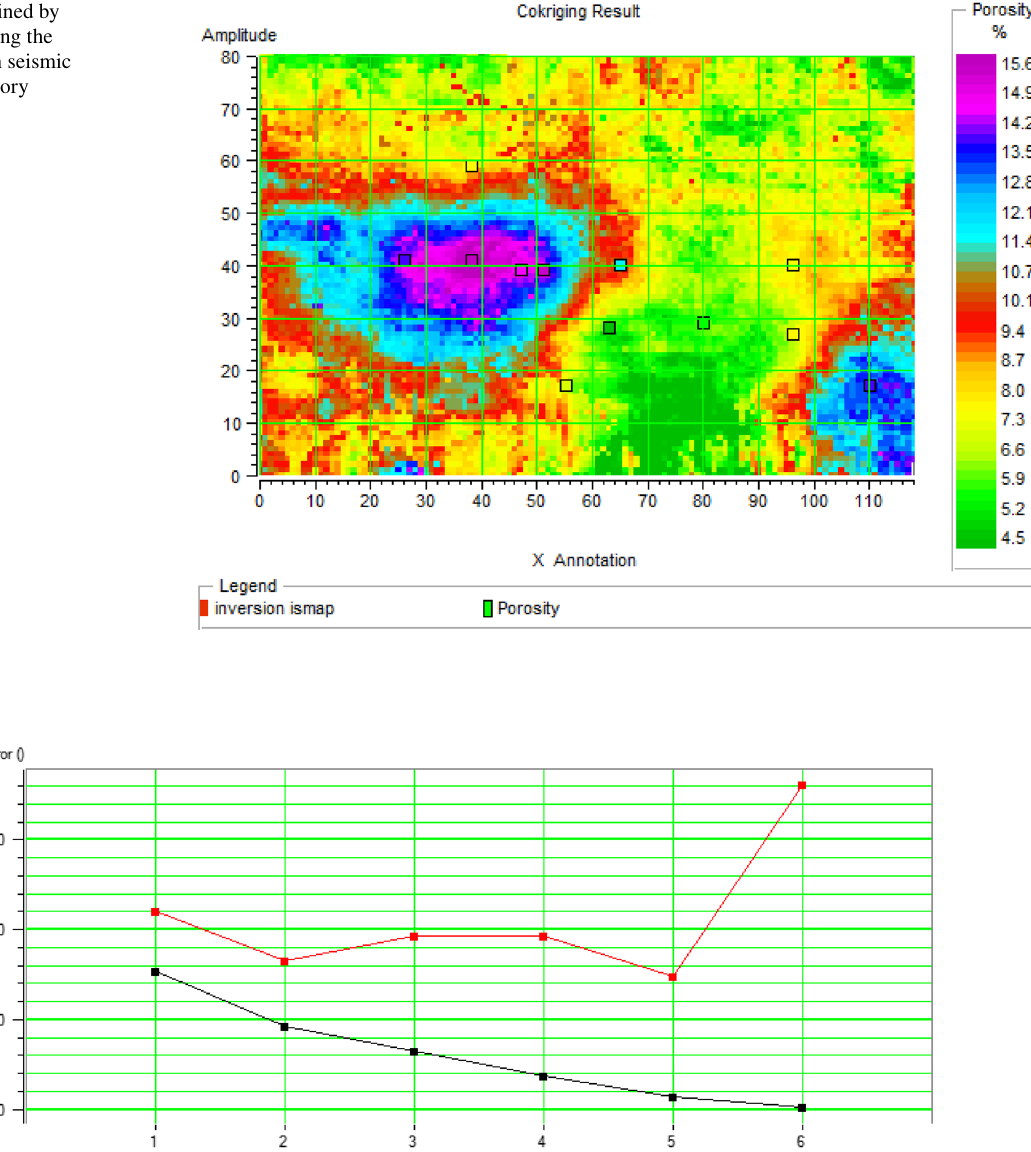
Fig. 30 Porosity obtained by dependent kriging using the dominant structure on seismic data in the third category